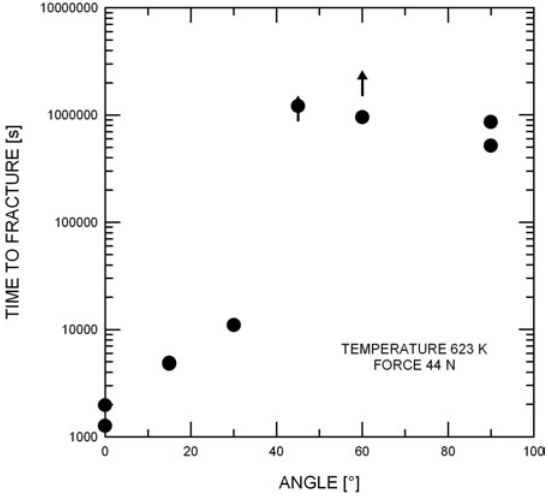
Figure 6. Dependence of the time to fracture on sample orientation.